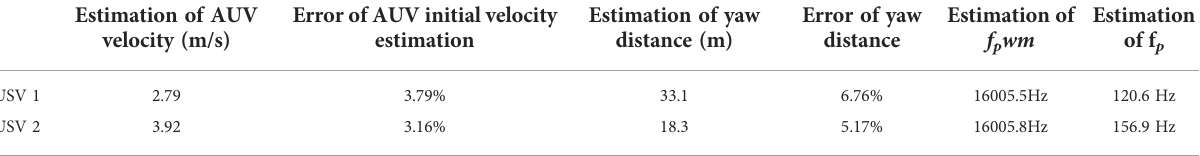
TABLE 2 Inversion calculation of USV circle navigation conditions and errors.